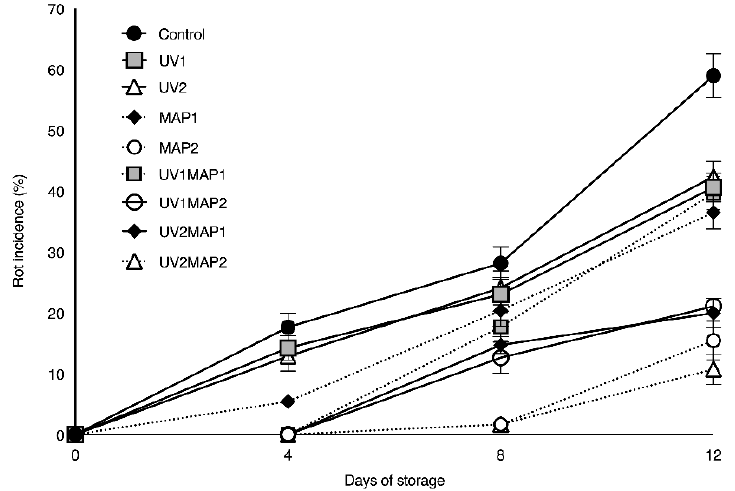
Figure 3. Evolution of rot incidence during shelf life of red raspberries stored in air (control), treated with UV-C (2 KJ m − 2 (UV1) or 4 KJ m − 2 (UV2)), packaged in MAP (MAP1 or MAP2) and their combinations. Values represent mean ± standard deviation ( n = 5 packages per batch and control day).